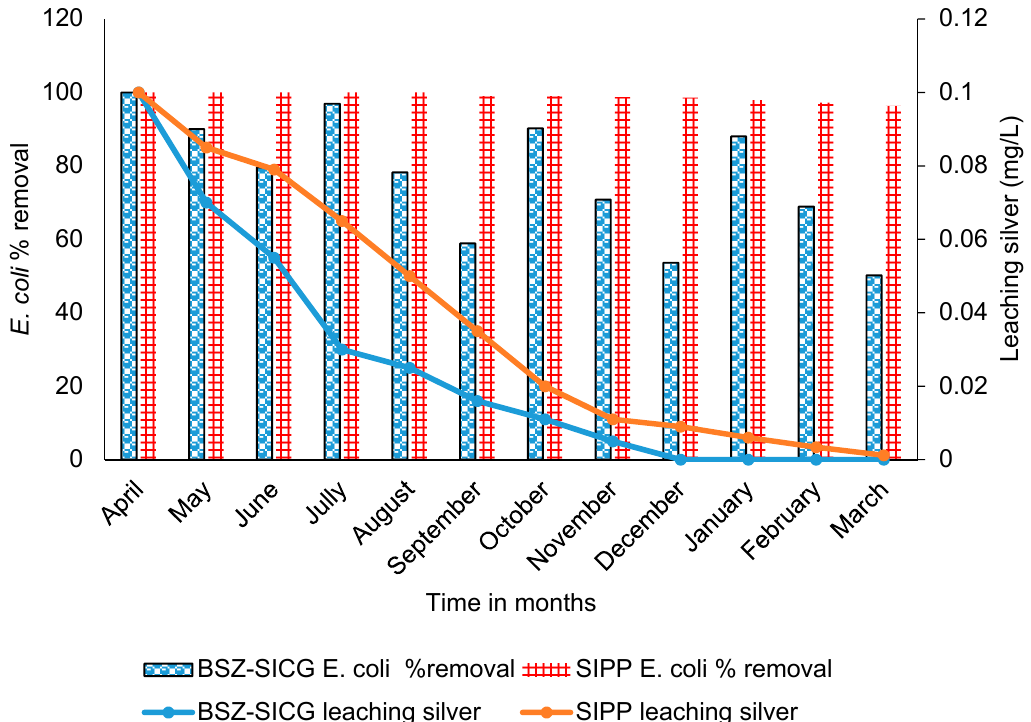
Figure 6. Arithmetic mean of E. coli % removal and the concentration of silver leached from the SIPP and BSZ-SICG into treated water versus the time in month.